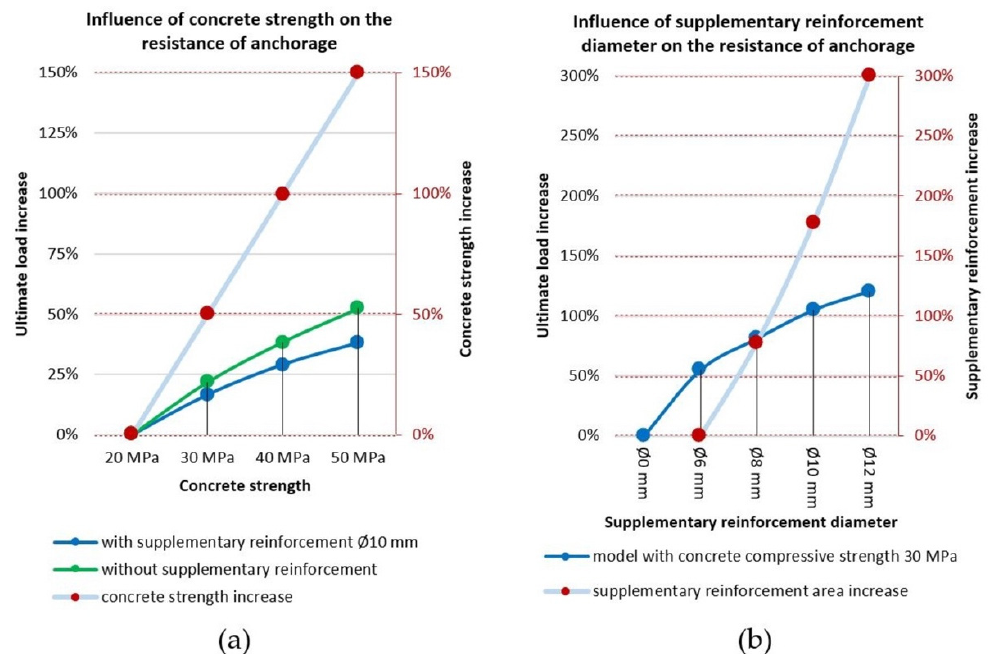
Figure 23. Ultimate load increase: ( a ) influence of the concrete compressive strength; ( b ) influence of the supplementary reinforcement.